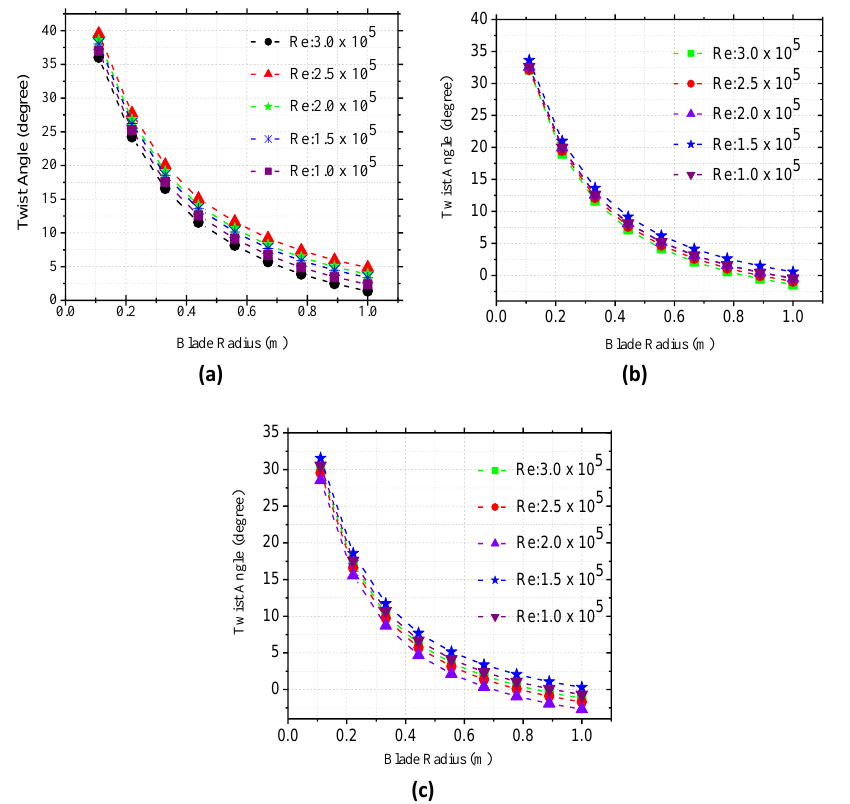
Figure 8. Blade optimum twist distributions for SG6043 airfoil at de ( a ) TSR 4; ( b ) TSR 5; ( c ) TSR 6.